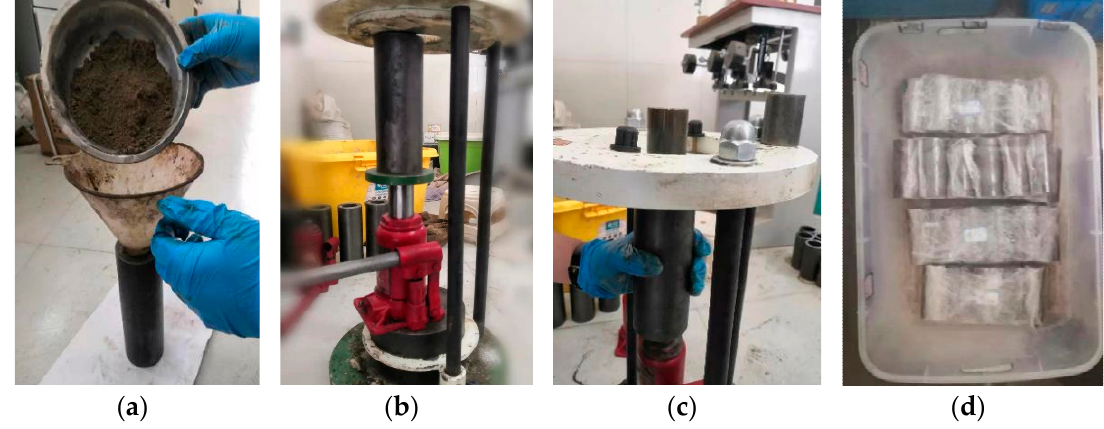
Figure 2. Sample preparation process: ( a ) filling; ( b ) standing; ( c ) demolding; ( d ) curing.